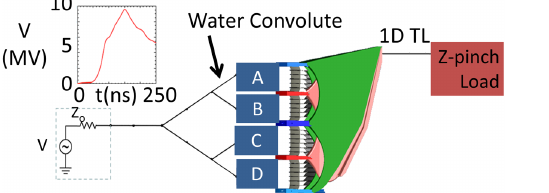
FIG. 16. Configuration for the Quicksilver simulations of the CSMITL and the circuit models that provided the input and output boundary conditions. The upper and lower modules branch with a water (dielectric) convolute to feed levels A, B, C, and D. The CSMITL simulation is illustrated in green and pink and is terminated in a one-dimensional transmission line and model of the z-pinch load.